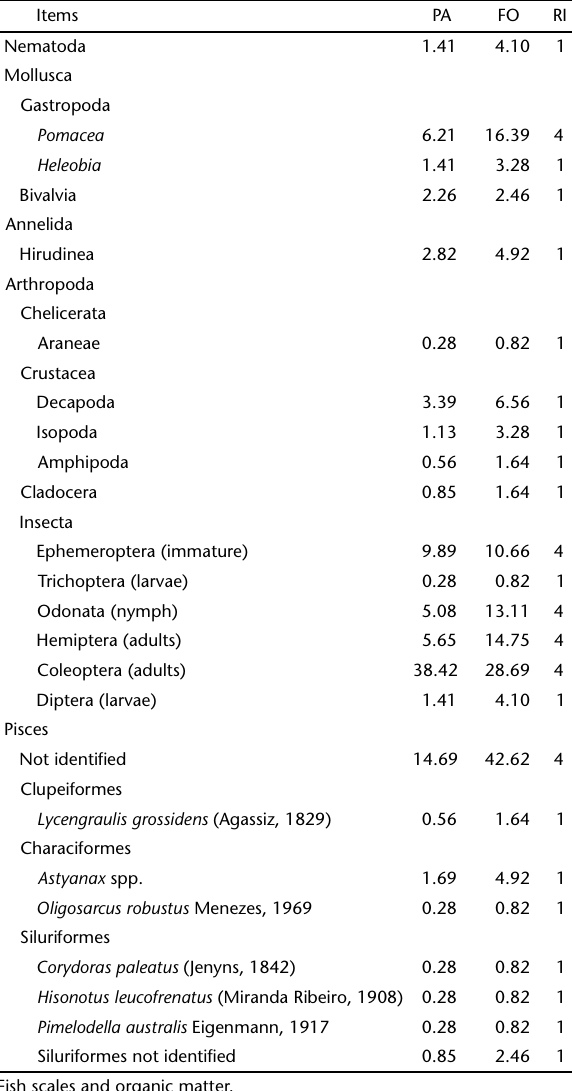
Table III. Percent abundance (PA), frequency of occurrence (FO) and relative importance (RI) of food items consumed by Trachelyopterus lucenai in Itapeva, Quadros and Malvas lagoons in the Tramandaí River system, Rio Grande do Sul. (1) present, (2) frequent, (3) abundant, (4) abundant and frequent, (*) fish scales and organic matter were present in all stomachs.